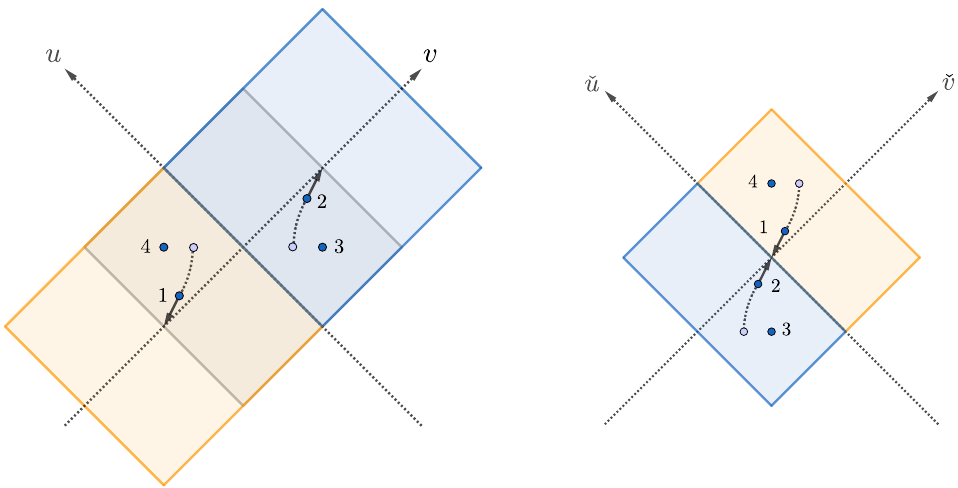
Figure 3 . [Left] The two di(cid:11)erent Minkowski patches covering the v > 0 (blue) and v < 0 (orange) regions, which are adapted to the Regge limit where the points 1 and 2 approach the origins in the each patch respectively. [Right] The Minkowski patch in the new coordinates glues upper-right and lower-left halves of the two Minkowski patches in the original coordinates. The points 1 and 2 are timelike-separated and approach the